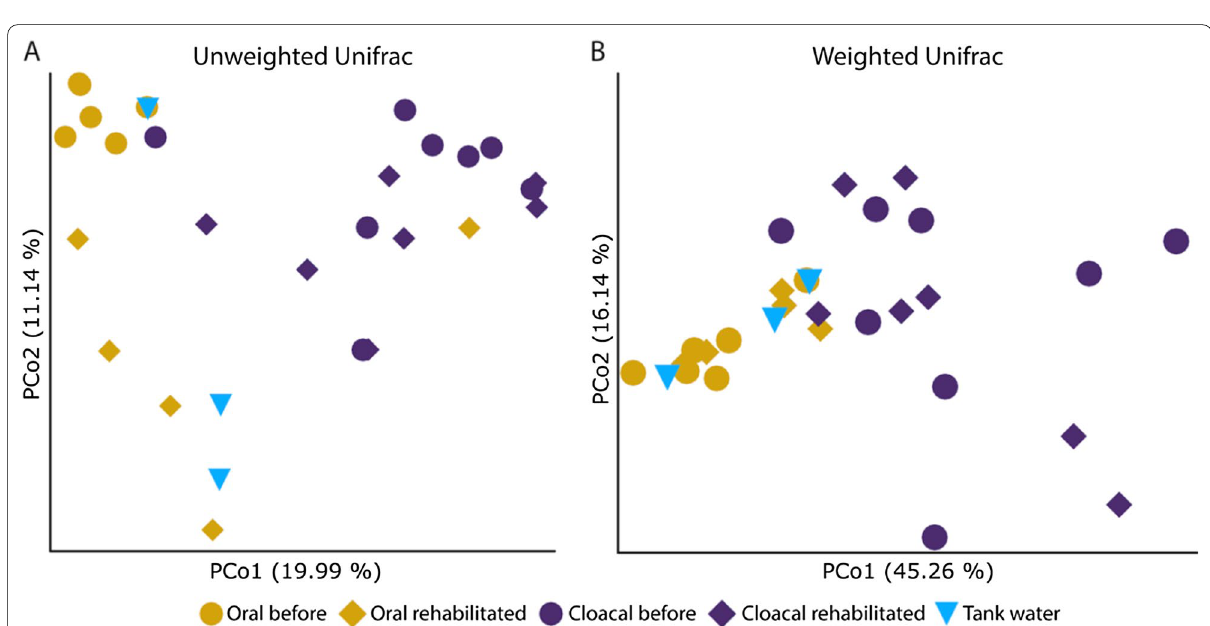
Fig. 3 Comparison of microbial diversity in loggerhead cloacal, oral and tank water samples. Principal component analysis (PCoA) plot of a Unweighted Unifrac and b Weighted